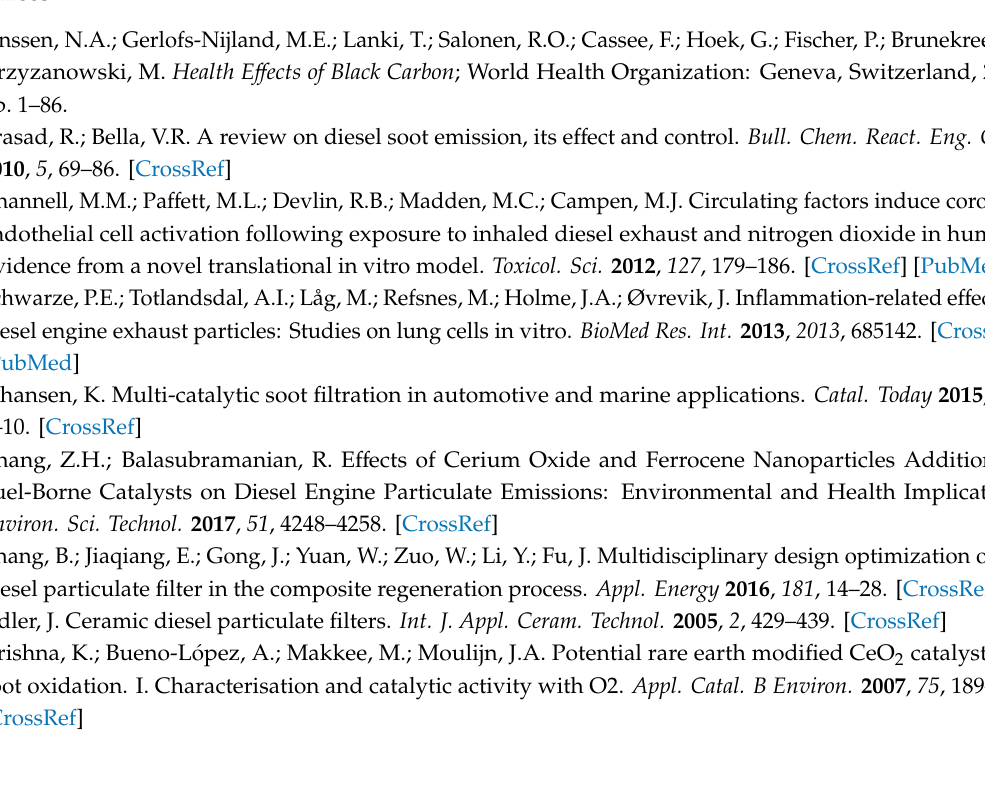
Table S1: FWHM (full width at half maximum) of the F 2g band from the CeO 2 lattice of Raman spectra. Given is the average of three repeated measurements and the standard deviation. FWHM is determined with the software Origin Pro 2019b; Table S2: Results of Rietveld-Refinement of the normal precipitation route. Samples are calcined by T = 800 ◦ C; Table S3: Results of Rietveld-Refinement of the reverse strike precipitation route. Samples are calcined by T = 800 ◦